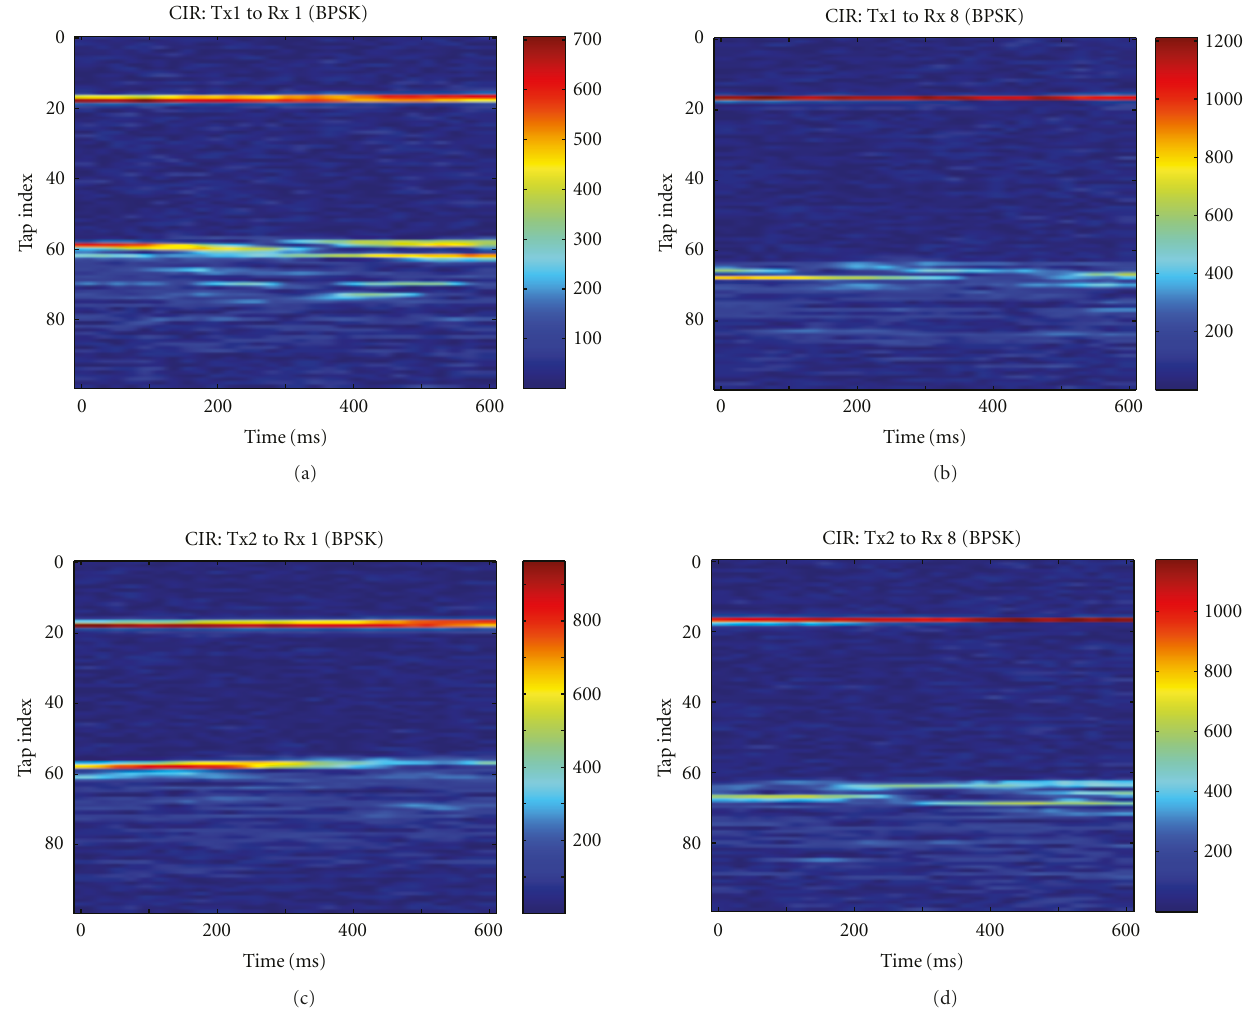
Figure 8: Demonstration of channel time variation within one packet (BPSK modulation).